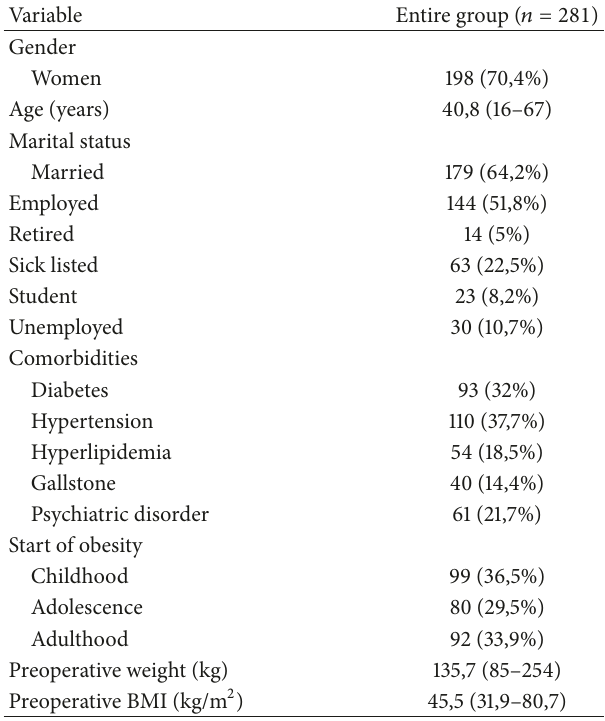
Table 1: Data expressed as 𝑛 (%) for nominal variables or mean (range) for continuous